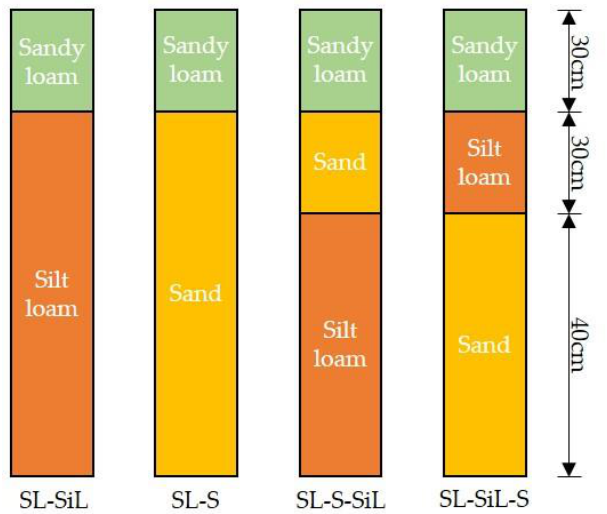
Figure 3. Experimental apparatus used in the infiltration and drainage process. Figure 3. E xperimental apparatus used in the infiltration and drainage process.